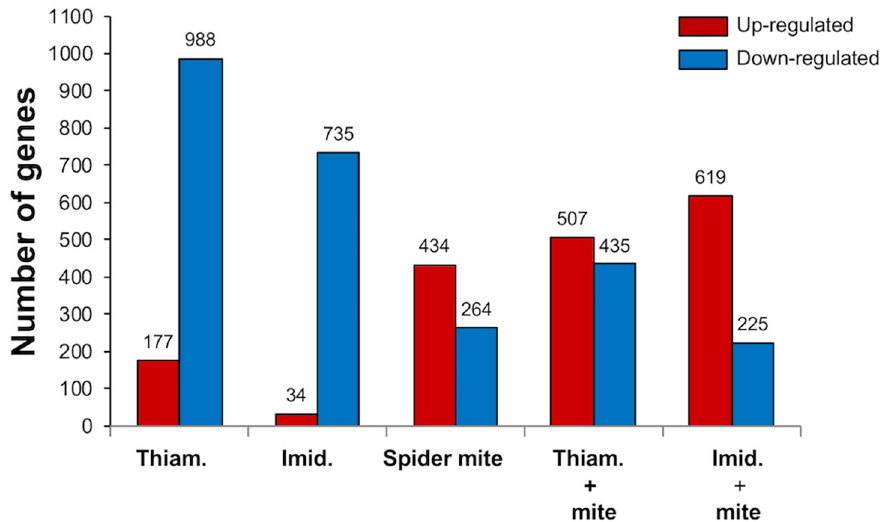
Figure 1. Differentially expressed genes (DEGs) in soybean plants exposed to thiamethoxam (Thiam.), imidacloprid (Imid.), spider mites, and the combination of the insecticides and spider mites. DEGs were defined as having a fold change ≥ 2 or ≤− 2 with a false discovery rate (FDR) adjusted p -value <0.05.